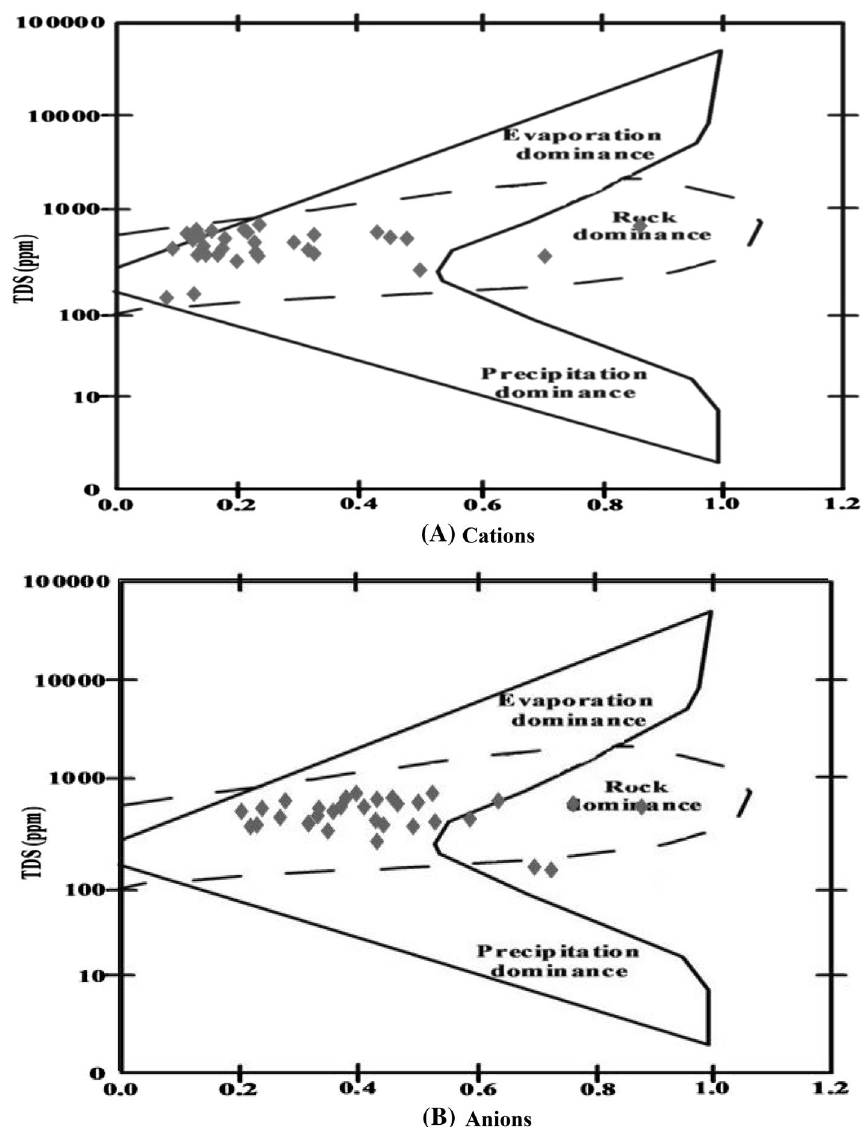
Fig. 34 Gibb’s diagram